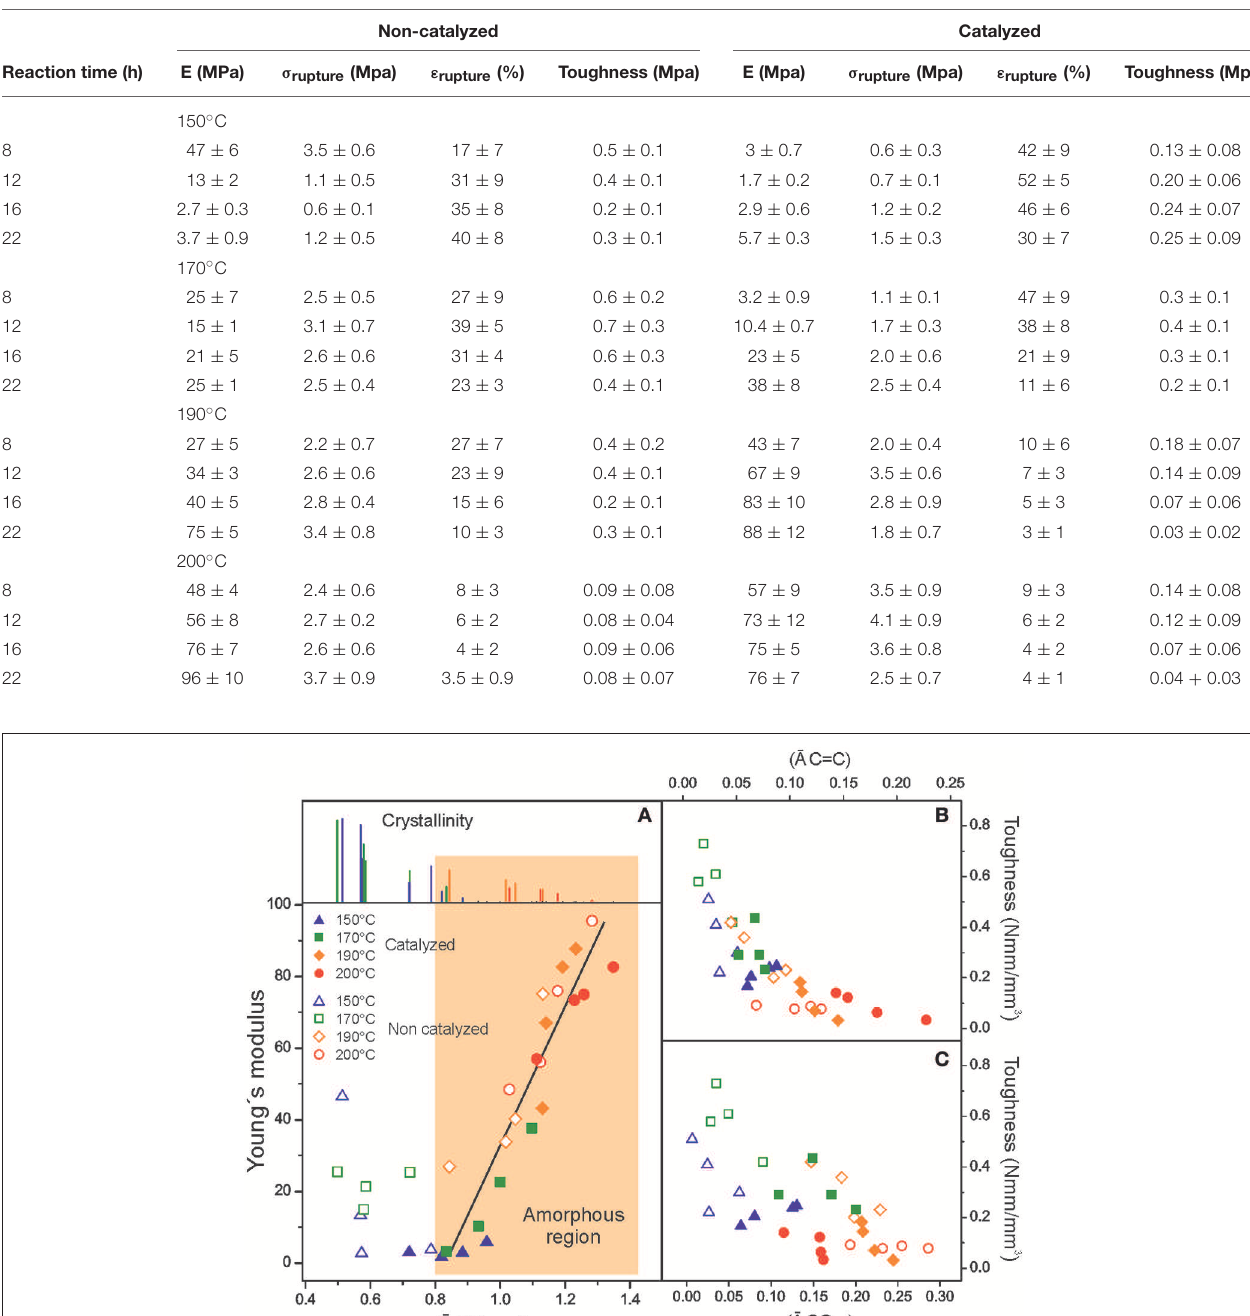
TABLE 2 | Tensile parameters for polyaleuritates prepared by melt-polycondensation in air. Non-catalyzed Catalyzed